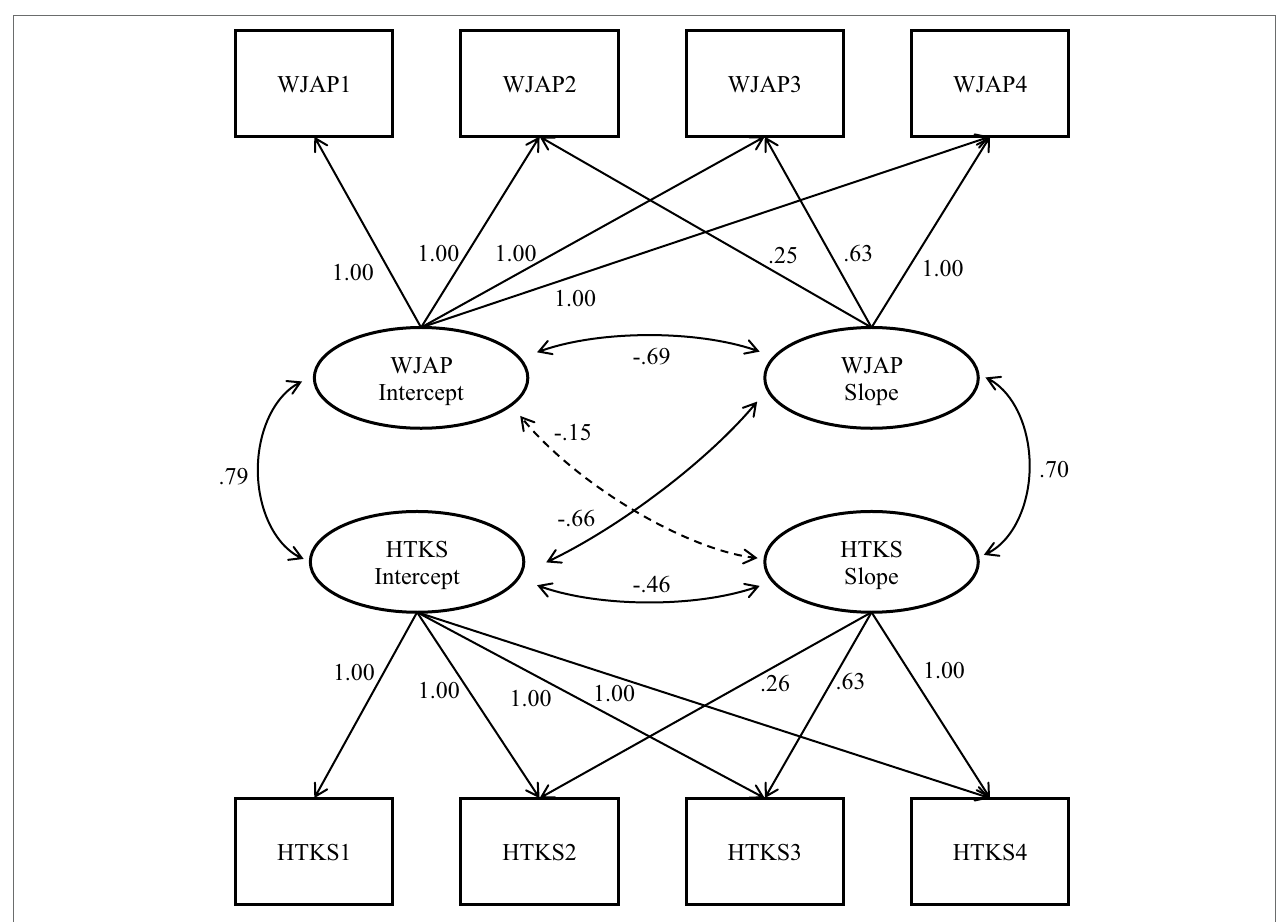
FIGURE 2 | Math and HTKS-R parallel process model. Values represent unstandardized factor loadings and standardized covariances. Significant covariances and factor loadings at p < 0.05 are displayed with solid lines. Non-significant are displayed with dashed lines. Analyses revealed the following model fit indices: CFI = 0.971; TLI = 0.966; AIC = 13837.487; BIC = 13906.848; RMSEA = 0.067; χ 2 (24) = 49.864, p = 0.002. WJLW = Woodcock Johnson Letter-Word subtest. HTKS-R, Head Toes Knees Shoulders –